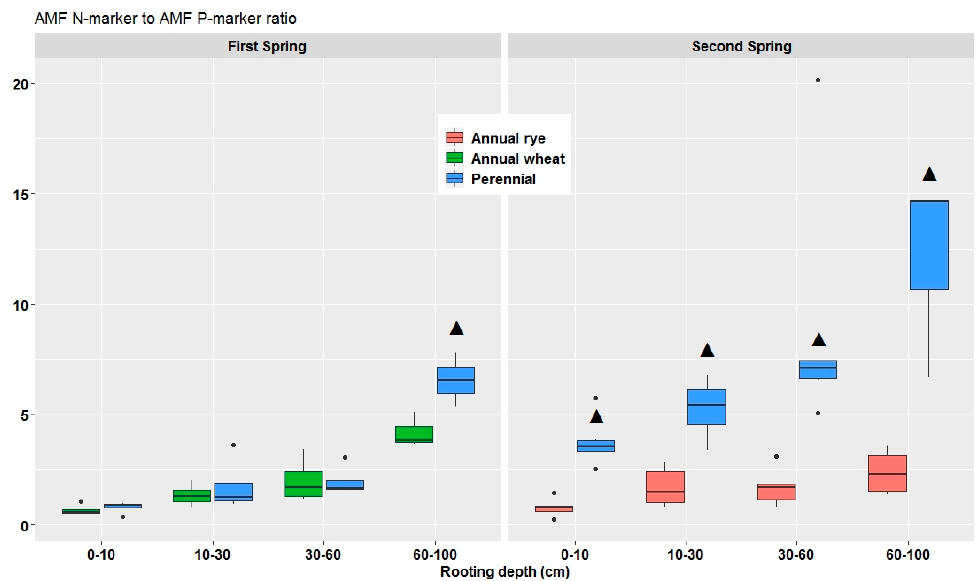
Figure 5. The PLFA and NLFA markers in annual wheat and intermediate wheatgrass, and between annual rye and the intermediate wheatgrass during the first and second growing seasons. Statistical differences (post hoc analyses) between annual and perennial grains are indicated by ★ . Error bars indicate standard errors, from 0 to 100 cm depth.